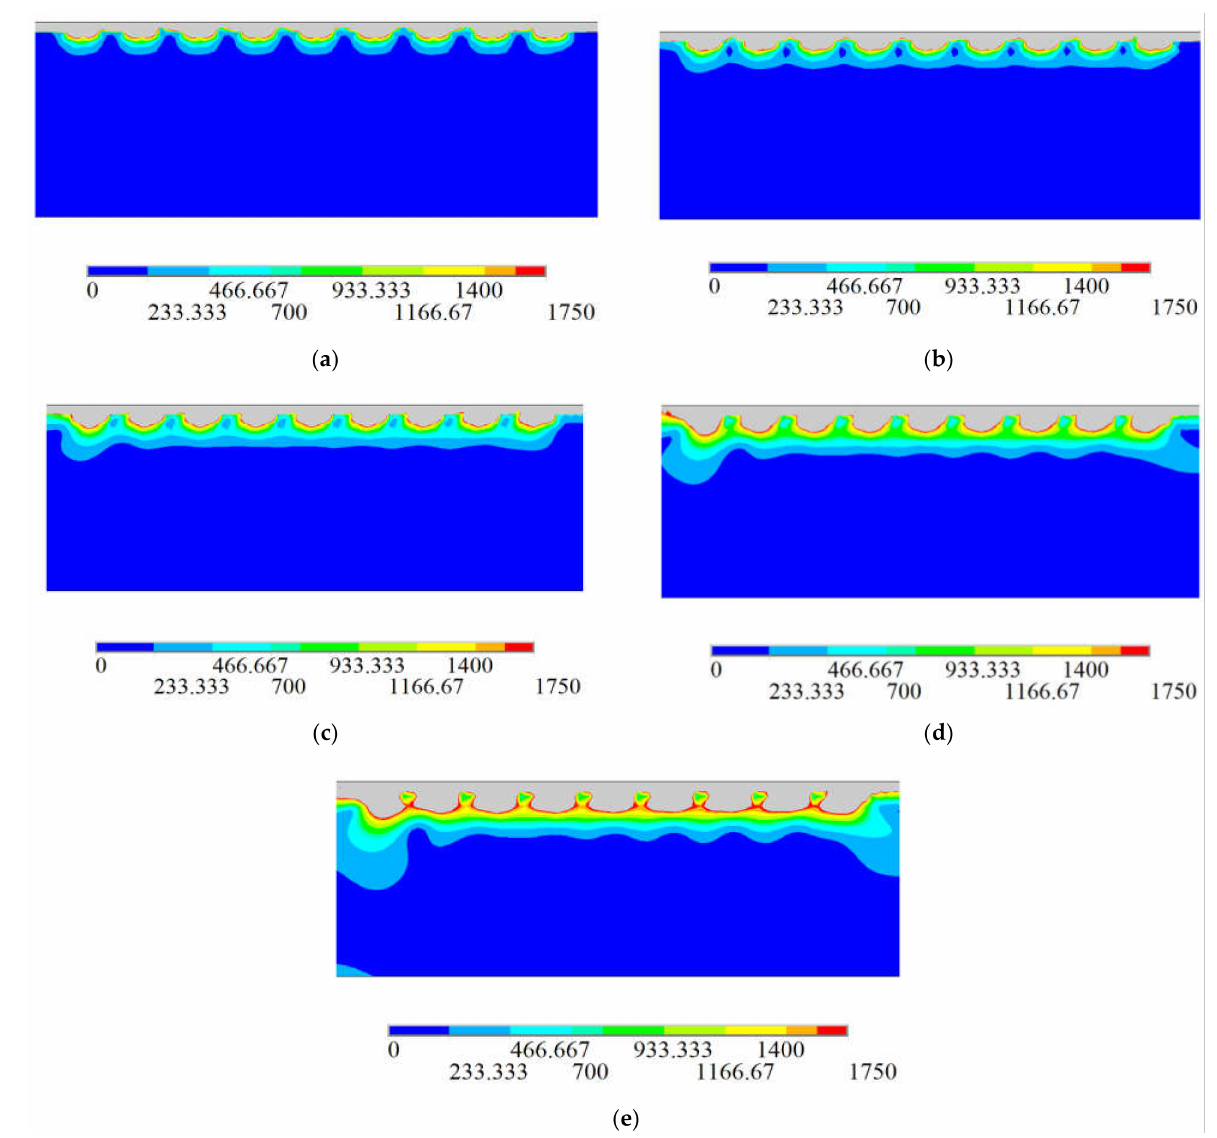
Figure 3. Stress cloud diagram of optical fiber under different film thickness t . ( a ) t = 60 nm; ( b ) t = 100 nm; ( c ) t = 150 nm; ( d ) t = 200 nm; ( e ) t = 250